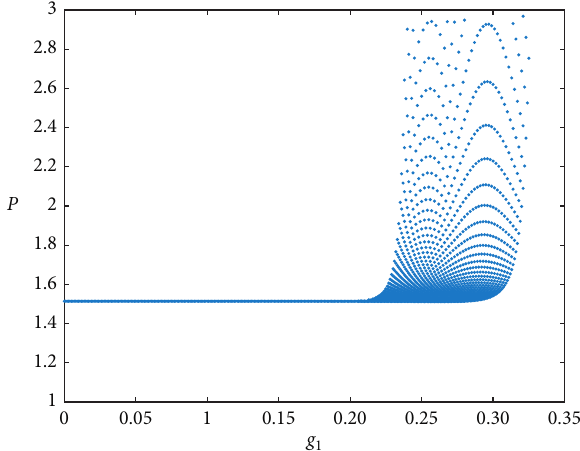
Figure 6: The effect of adjustment factors on leadership